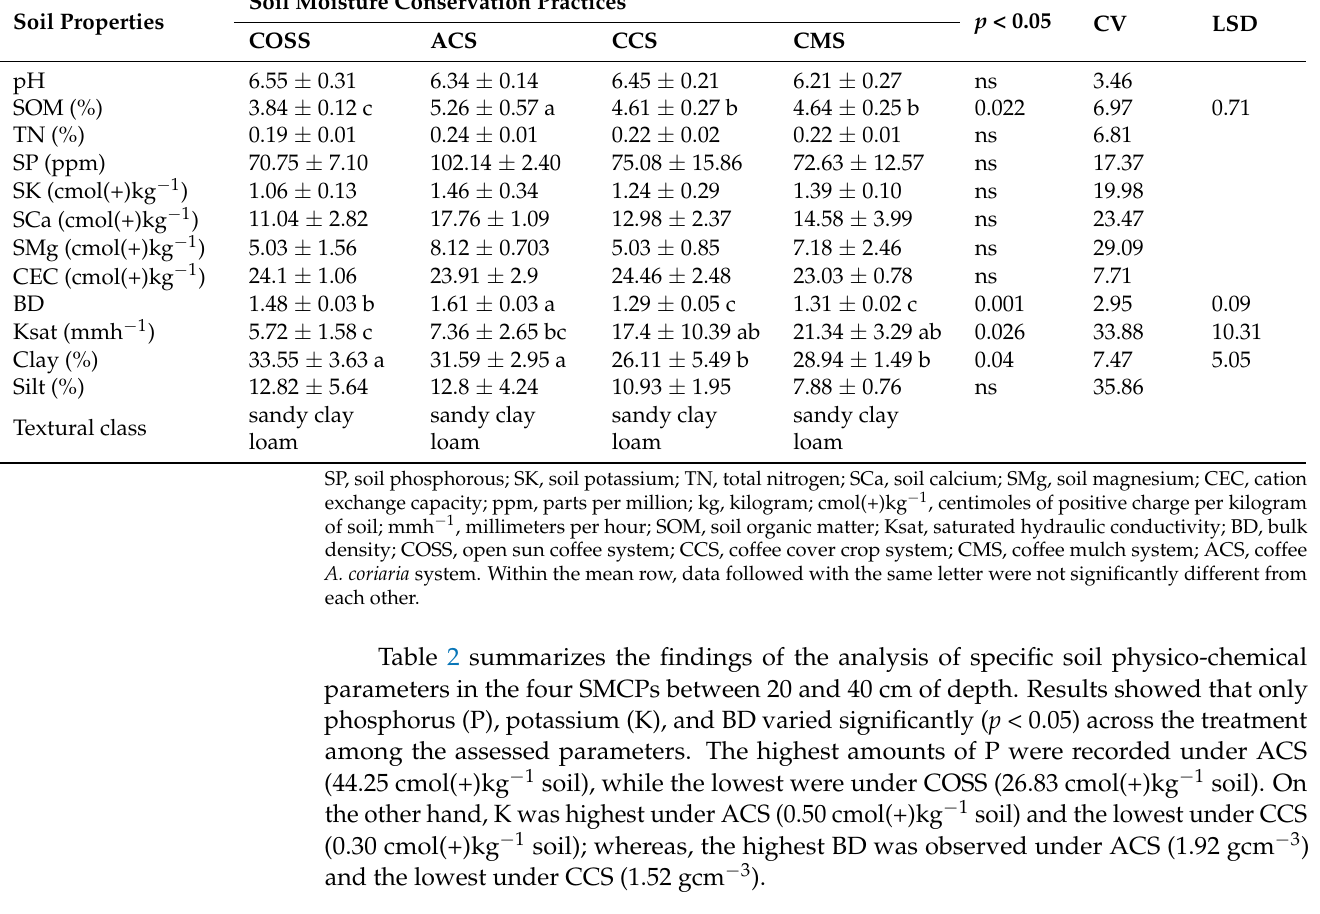
Table 2. Mean ± SD of selected soil (20–40 cm) physical and chemical properties across the four